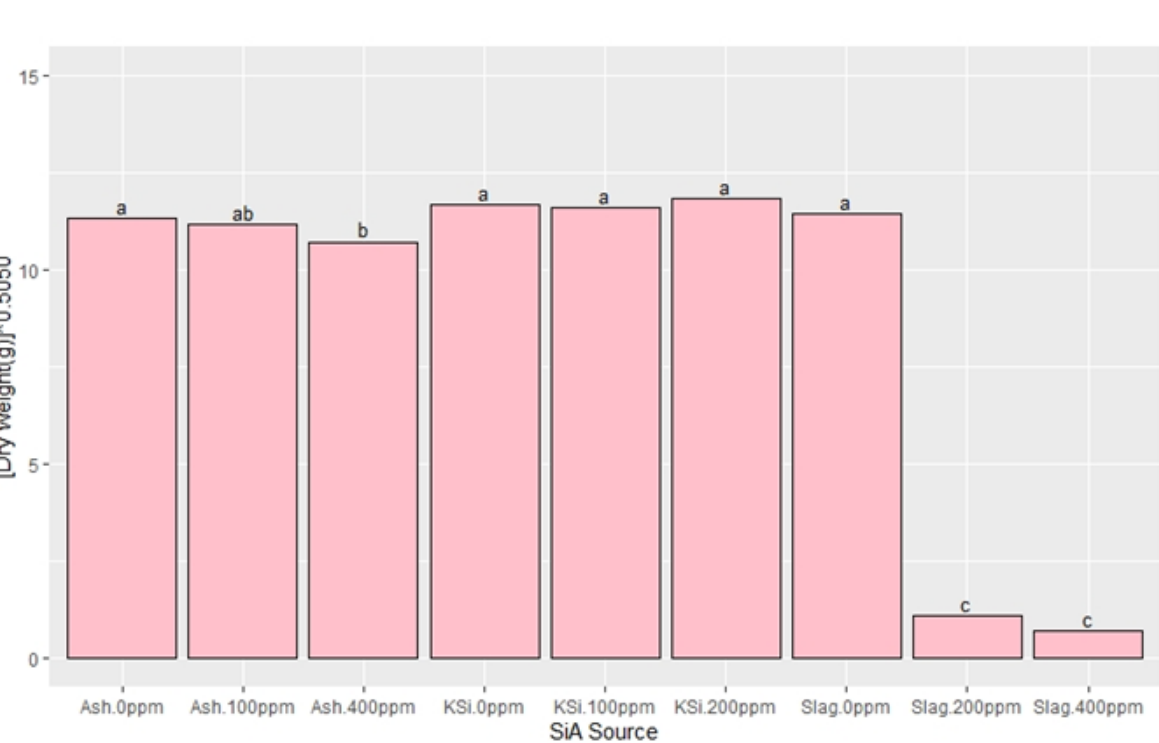
Figure 9 . Statistical summary of whole plant’s [Dry weigh = 0.05. Ash stands for rice husk ash; KSi, for potassium silicate and Slag, for ladle furnace